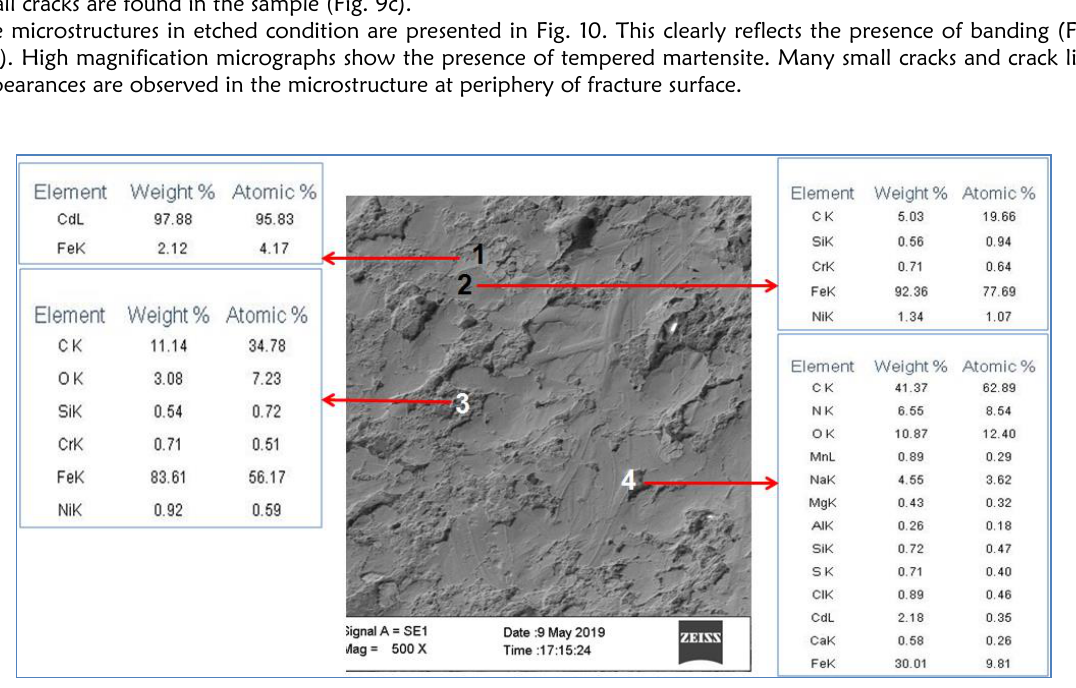
Fig. 7: High magnification images of region D in Fig. 5a and (b-e) EDS data taken from the locations 1, 2, 3 and 4. The fracture surface of failed bolt shank is shown in Fig. 8 after Branson cleaning. Cadmium is not found in region 2 after this cleaning. This reveals the presence of micro-cracks throughout the rubbed fracture surface.